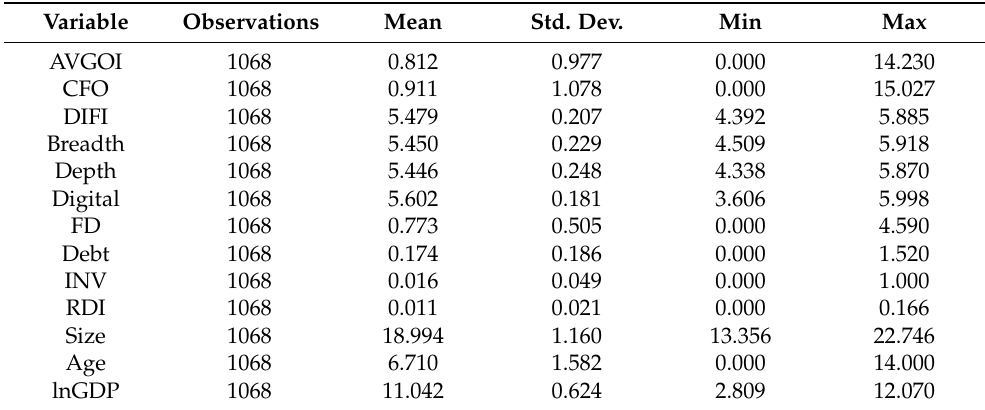
Table 2. Descriptive statistics of variables.